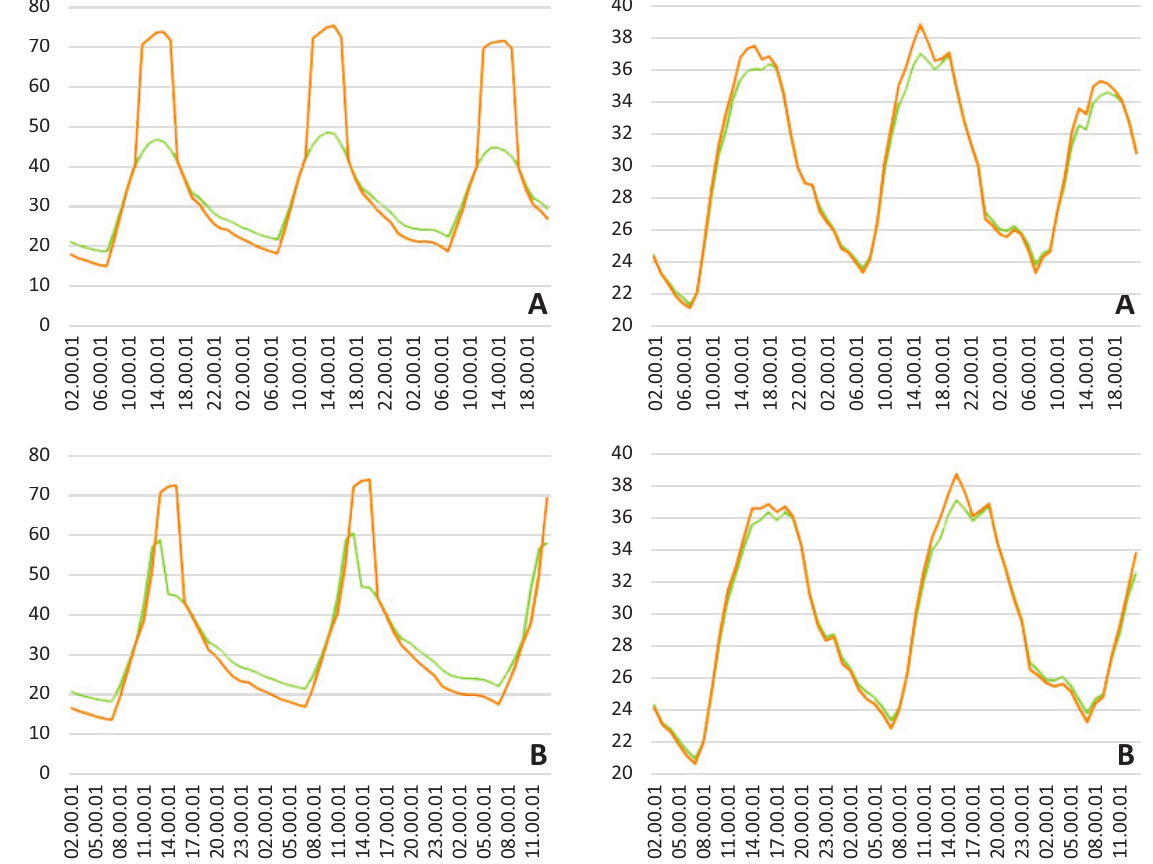
Figure 4. Comparison between the existing state of the case study (orange) and the intervention plan (green) looking at the MRT and PAT for the duration of the simulation at 1.5 m, generated on ENVI‐met. Notes: The left side graphs show the MRT, and the right side shows the PAT; points A and B can be spotted on the map in Figure